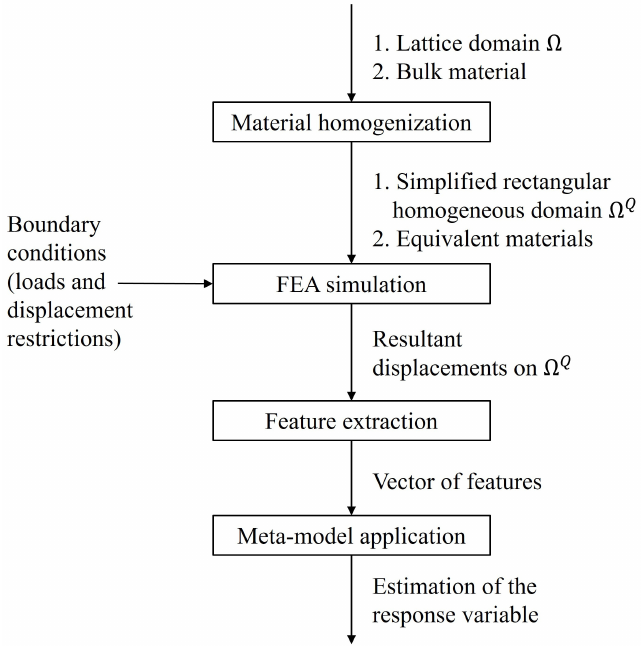
Figure 2. Work-flow for the estimation of the mechanical response of lattice domains using material homogenization and design of experiments